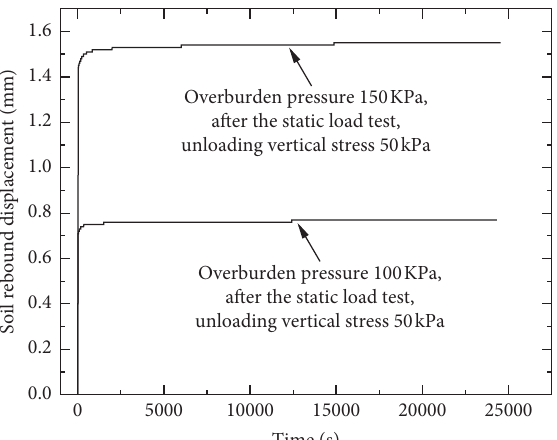
Figure 13: Soil rebound displacement versus time plots.